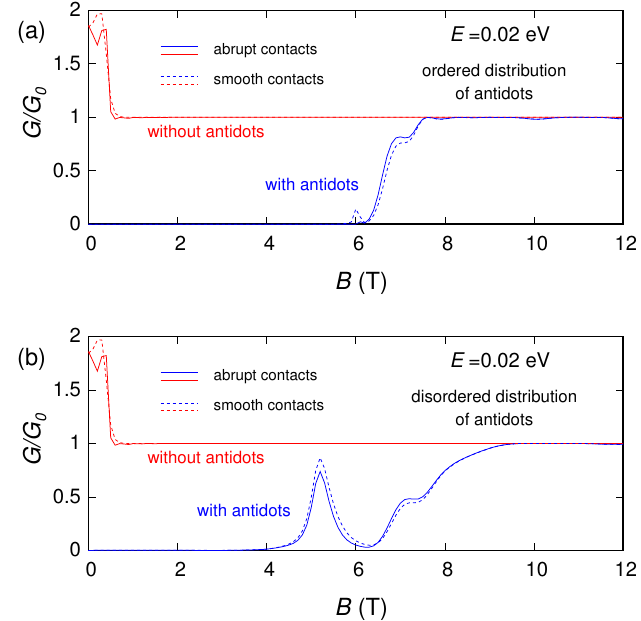
Figure 3. Normalized conductance of the graphene ribbon as a function of the orthogonal magnetic field, obtained for E = 0.02 eV in the presence of an ordered (panel ( a )) and a disordered (panel ( b )) distribution of antidots, compared with the conductance of the ribbon without